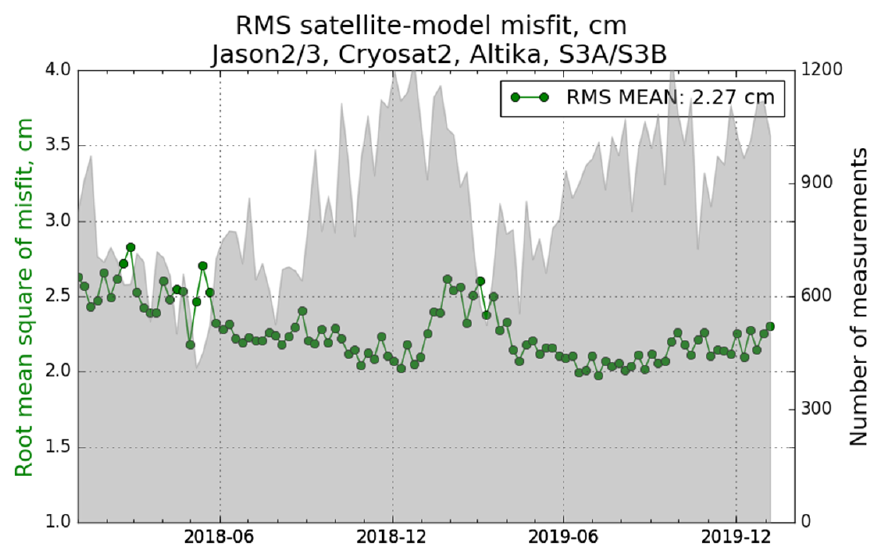
Figure 4. RMSE misfit of SLA, expressed in cm, computed using available observations from Altika, Cryosat-2, Jason-2 and 3, Sentinel-3A and 3B during 2018–2019.